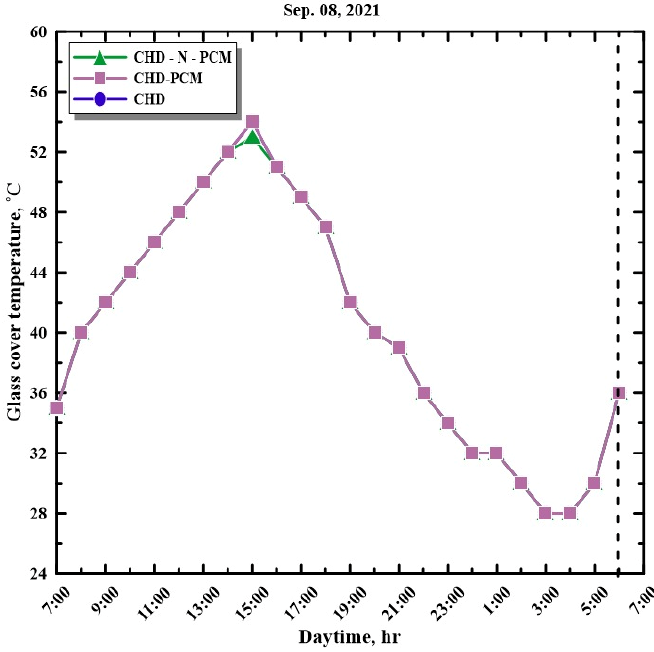
Figure 8. Hourly variation in glass cover temperature with time.